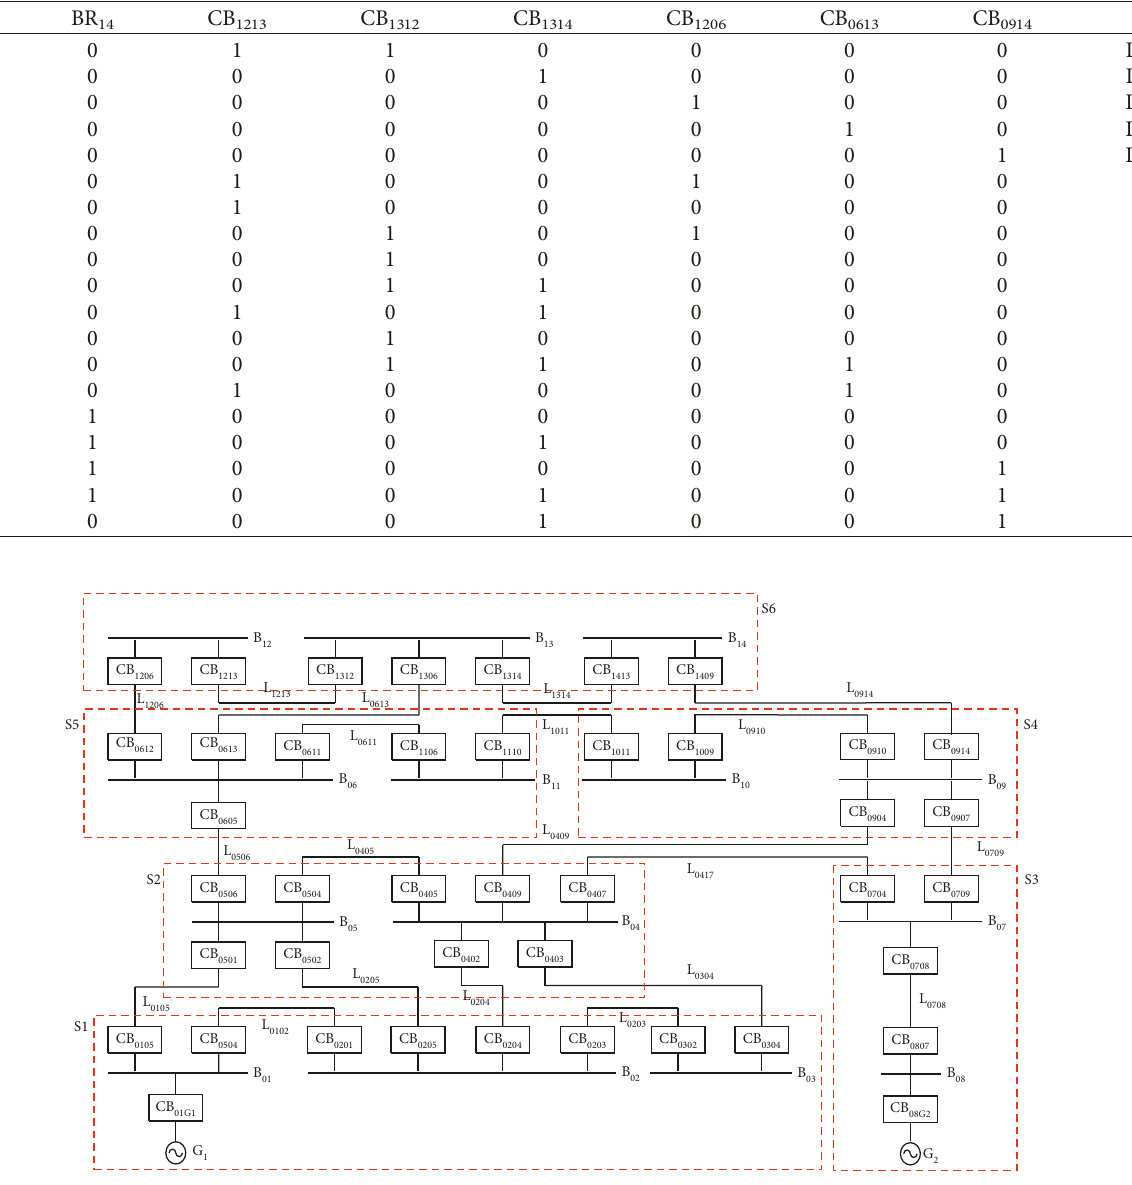
Table 3: Minimum reduction decision table of